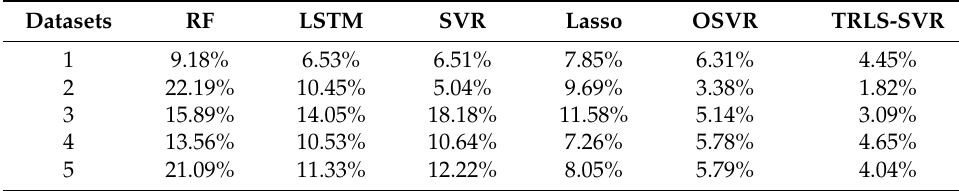
Table 5. MAPE of different methods in five datasets.